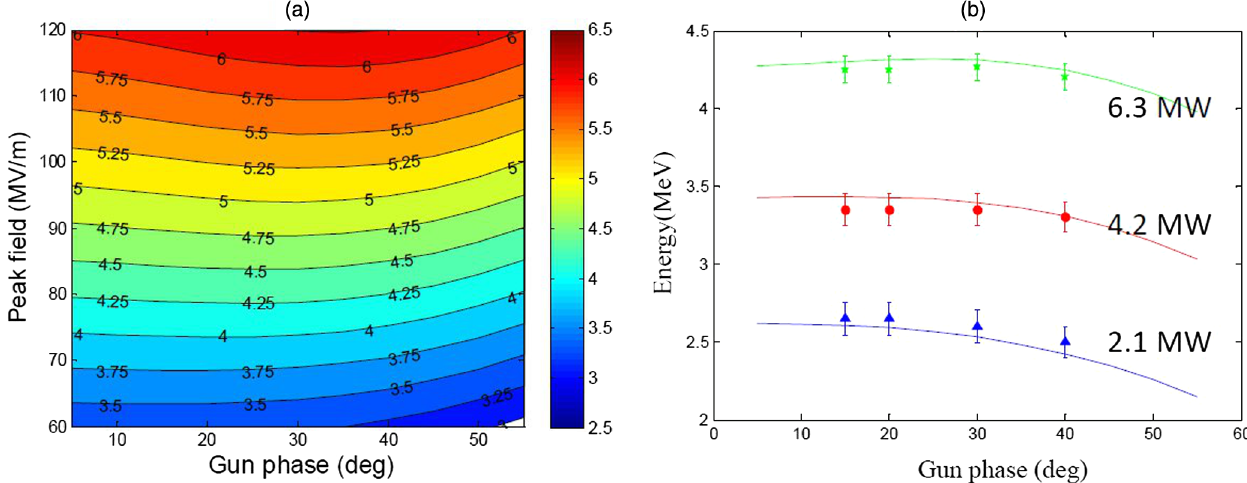
FIG. 16. (a) Theoretical maximum electron energy as a function of rf phase for different cathode peak field; (b) measured electron beam energy as a function of phase and for different power into the